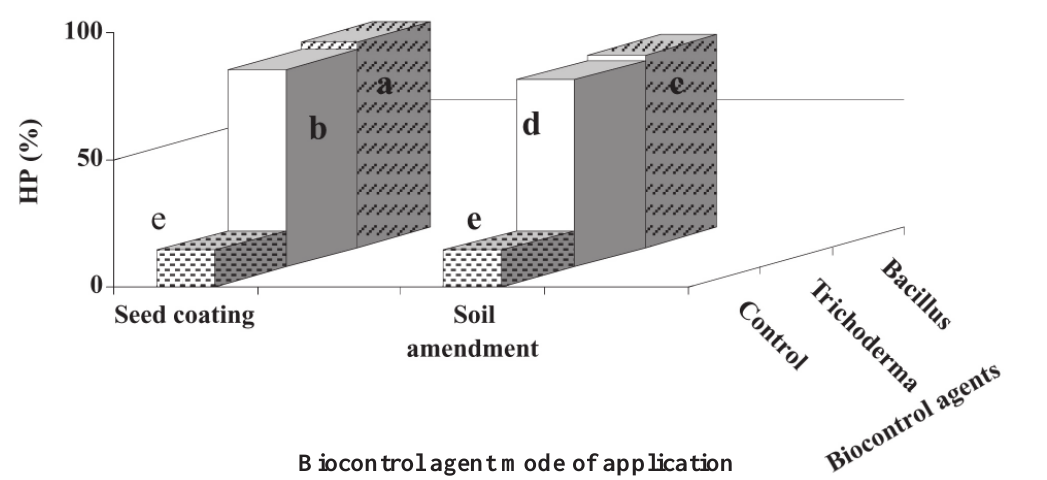
Fig. 1. Pot evaluation of the effect of the means of application (seed coating; soil amendment) of two biocontrol agents ( Bacillus subtilis , Trichoderma pseudokoningii ) on the percentage of healthy plants (% HP) of broad bean grown in Fusarium infested soil. In the control the seeds did not receive any treatment. LSD=1.1658. Means with the same letter are not significantly different ( P